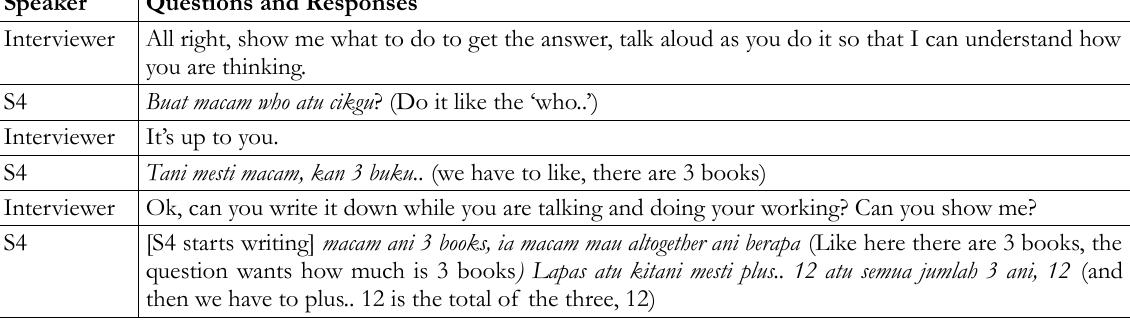
Table 9. Interview excerpts from student